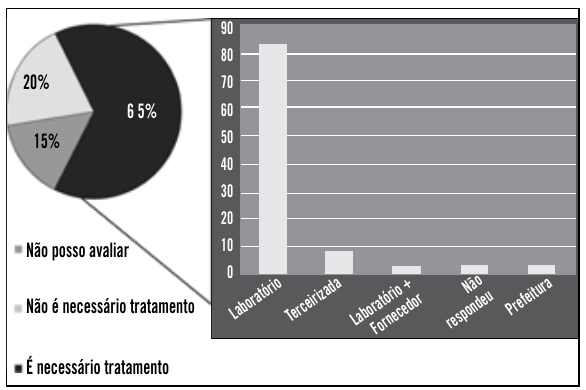
Figura 3 – Resultado da pesquisa realizada com os 34 laboratórios sobre o tratamento do descarte do equipamento de hematologia e a opinião sobre a responsabilidade de tratar o descarte dos